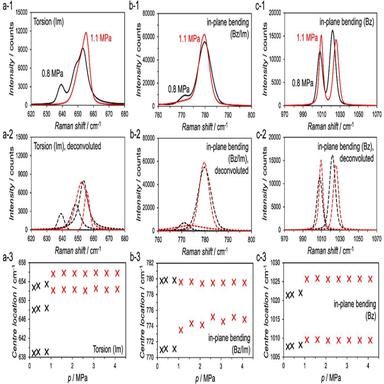
Vibrational mode analysis of ZIF-7 in methane system across the gate opening (breathing) transition for panel a: torsion of imidazole ring (Im), panel b: inplane bending through benzene and imidazole ring, and panel c: in-plane bending within benzene ring (Bz); each sub-panel presents for 1: acquired Raman spectrum, 2: deconvolution of the spectrum shown in (1), and 3: a peak center location of each deconvoluted peak.